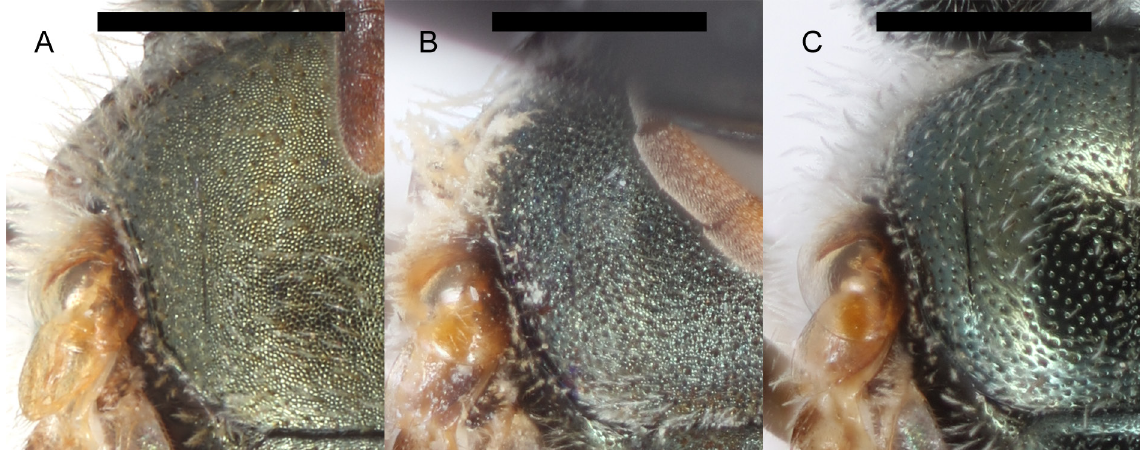
Fig. 93. Mesoscutum. A . Lasioglossum ( D. ) tessellatosum sp. nov., ♀, with strong microsculpture and sparse punctures. B . L. ( D. ) droegei Gibbs, 2009, ♂, with strong microsculpture and dense punctures. C . L. ( D. ) cactorum sp. nov., ♀, shiny and sparsely punctate. Scale bars: 0.5 mm.